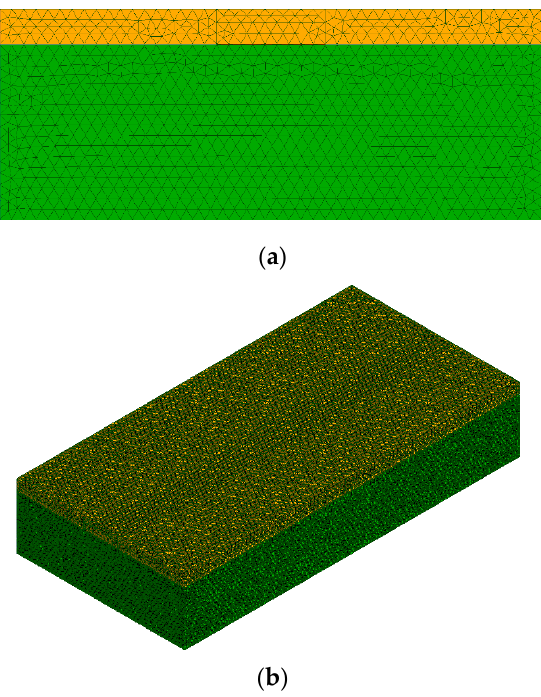
Figure 2. Images of 2D ( a ) and 3D ( b ) models.